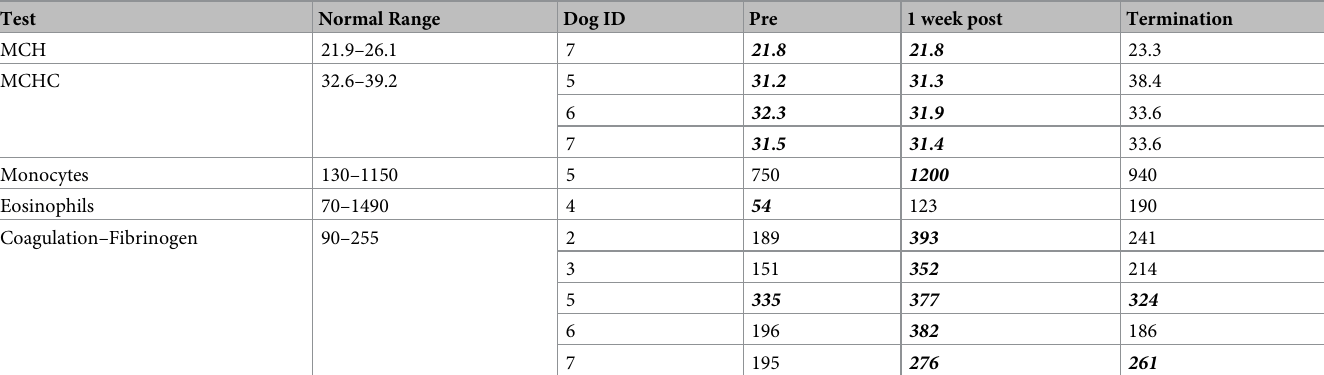
Table 7. Hematology.